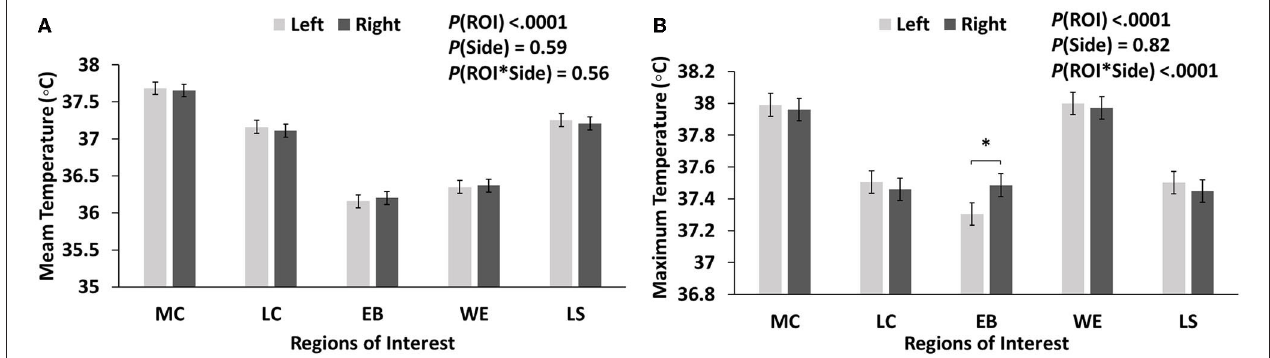
FIGURE 2 | Mean (A) and maximum temperature (B) of left and right eyes obtained at five regions of interest (ROIs). Data are graphed using the least square mean ± standard error of the interaction (ROI by side). MC, medial canthus; LC, lateral canthus; EB, eyeball; WE, whole eye; LS, lacrimal sac.